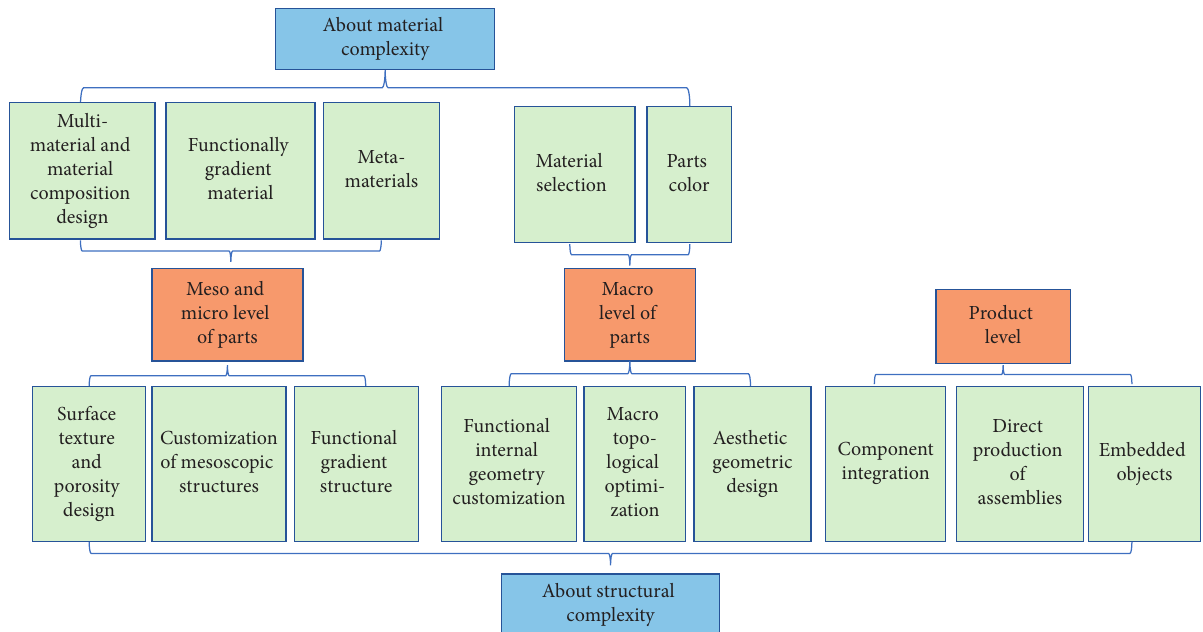
Figure 1: Design freedom of additive